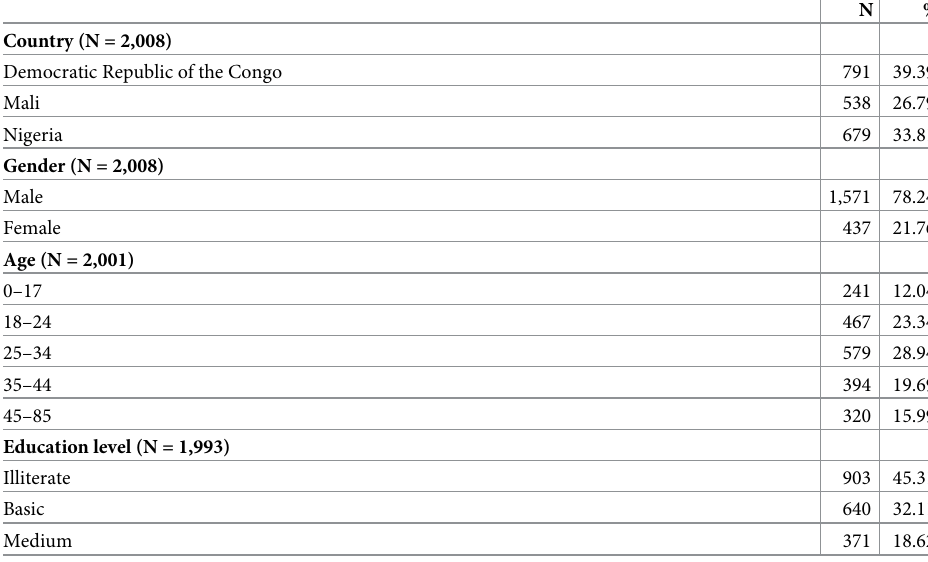
Table 1. Characteristics of the study population and the